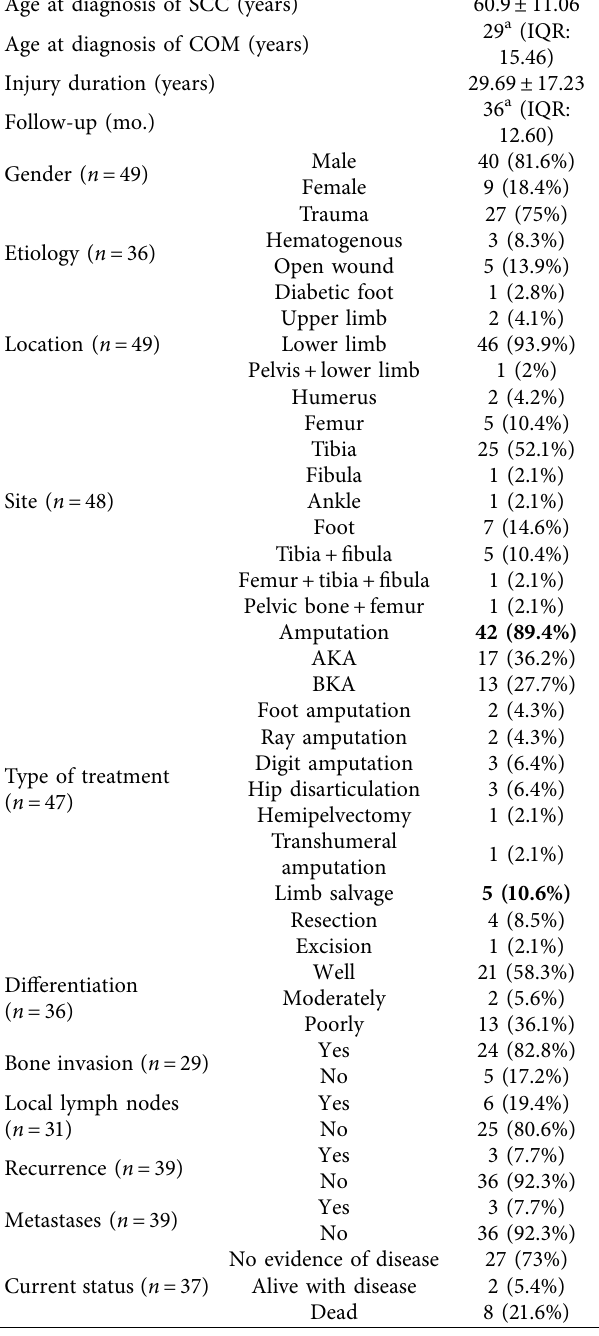
Table 2: Demographic and clinical characteristics, and treatment modalities for patients with chronic osteomyelitis-derived squa- mous cell carcinoma. Data displayed with ± symbol refers to the standard deviation, while data in parenthesis refers to the per- centage of patients. IQR: interquartile range, COM: chronic oste- omyelitis, AKA: above-the-knee amputation, BKA: